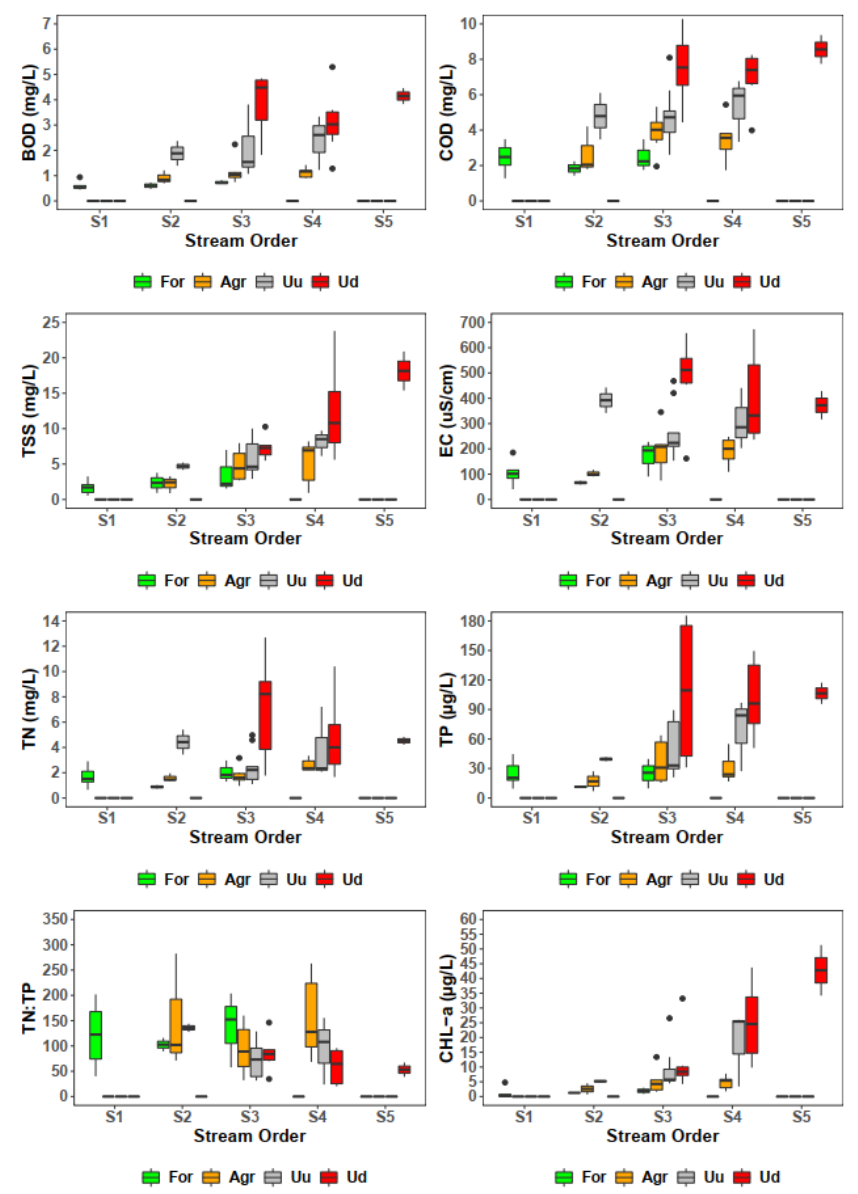
Figure 7. Variations of organic matters (BOD, COD), suspended solids (SS) and electric conductivity (EC), nutrients (TN, TP), TN:TP, and Chl-a based on land-use patterns and stream order (green: forest region, orange: agriculture region, grey: urban upstream region, red: urban downstream region, S1 – S5: stream order 1 – 5).